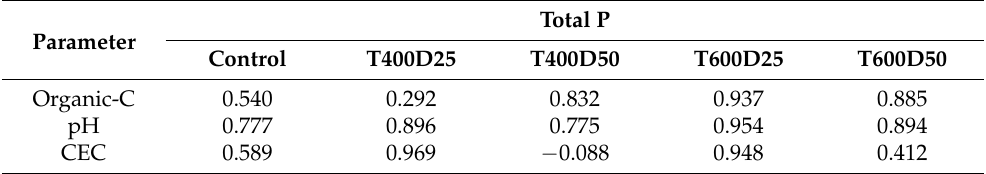
Table 2. Pearson correlation analysis of total P with organic-C, pH, and CEC. Total P Parameter Control T400D25 T400D50 T600D25 T600D50 Organic-C 0.540 0.292 0.832 0.937 0.885 pH 0.777 0.896 0.775 0.954 0.894 CEC 0.589 0.969 − 0.088 0.948 0.412